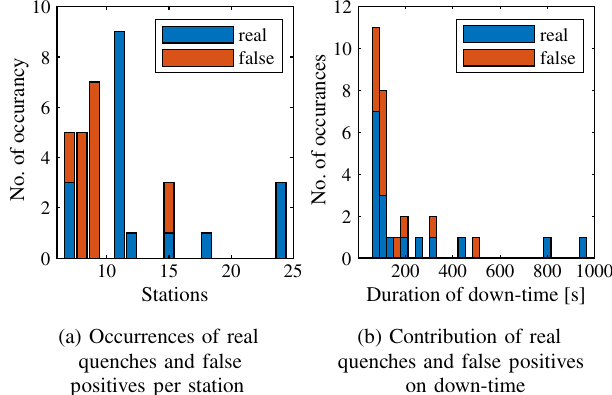
FIG. 2. Statistics of archived events triggered by the quench detection and reaction